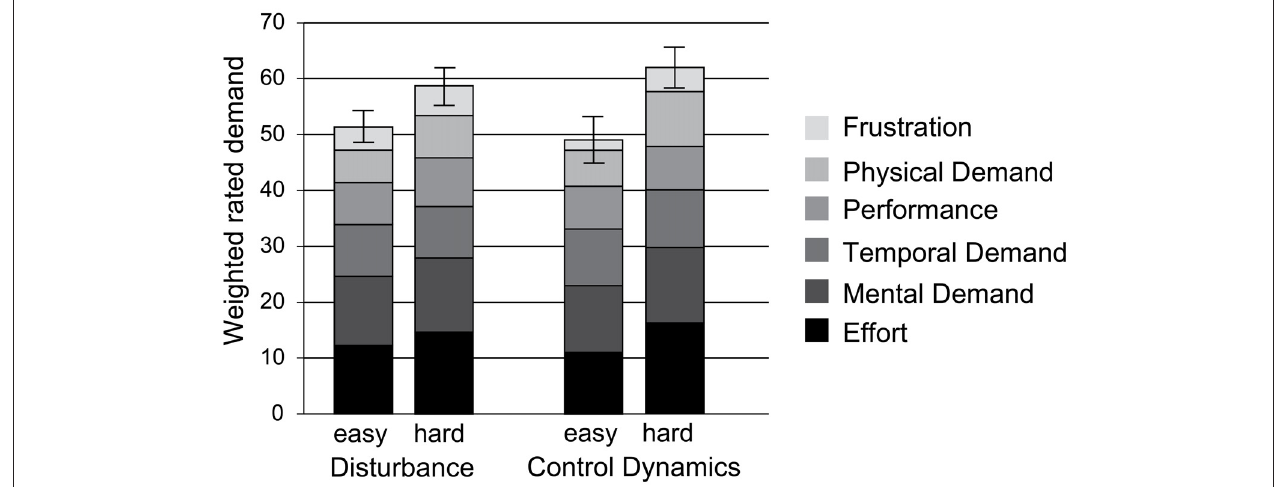
FIGURE 2 | Weighted sum of the six subscales of the NASA-TLX that were perceived by the participants as contributing to the overall workload. The error bars represent the 95% confidence interval.